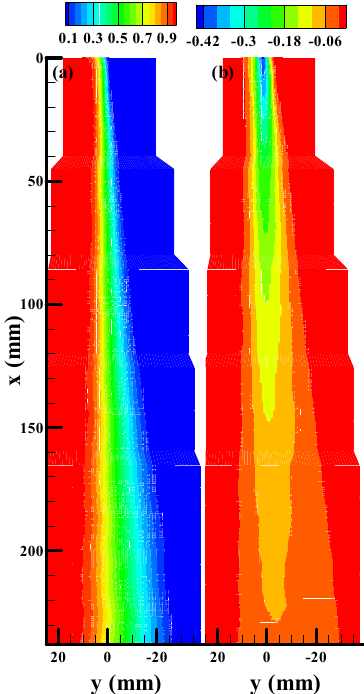
U U − ) and (b) Figure 3 Contours of (a) mean stream-wise velocity, normalized by ( H L / ) U y ∂ ∂ shear-induced component of mean span-wise vorticity, normalized by ( 0,max under the condition of R = 0.67 and Re = 624. θ result, the transport mechanisms for the Ω component in the neighborhood around the SH edges of shear layer are consisted of the advection (I) and diffusion (II) processes merely after achieving the self-preserving state. It hints that the shear-induced vorticity could be a suitable flow property to mark the boundary of a shear layer, from the point of view to distinguish the shear turbulence (shear layer) from homogeneous turbulence (free-stream regions). A new definition of the mixing length in terms of the shear-induced vorticity field is, then, proposed by